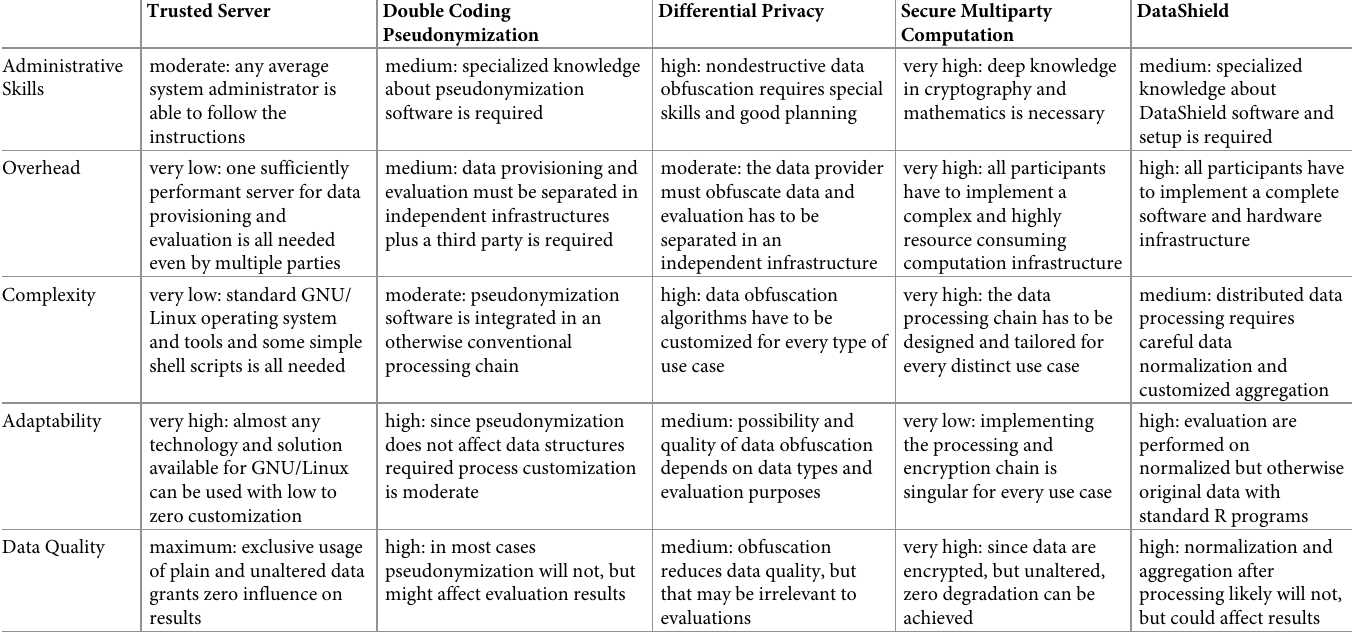
Table 1. Trusted Server versus established